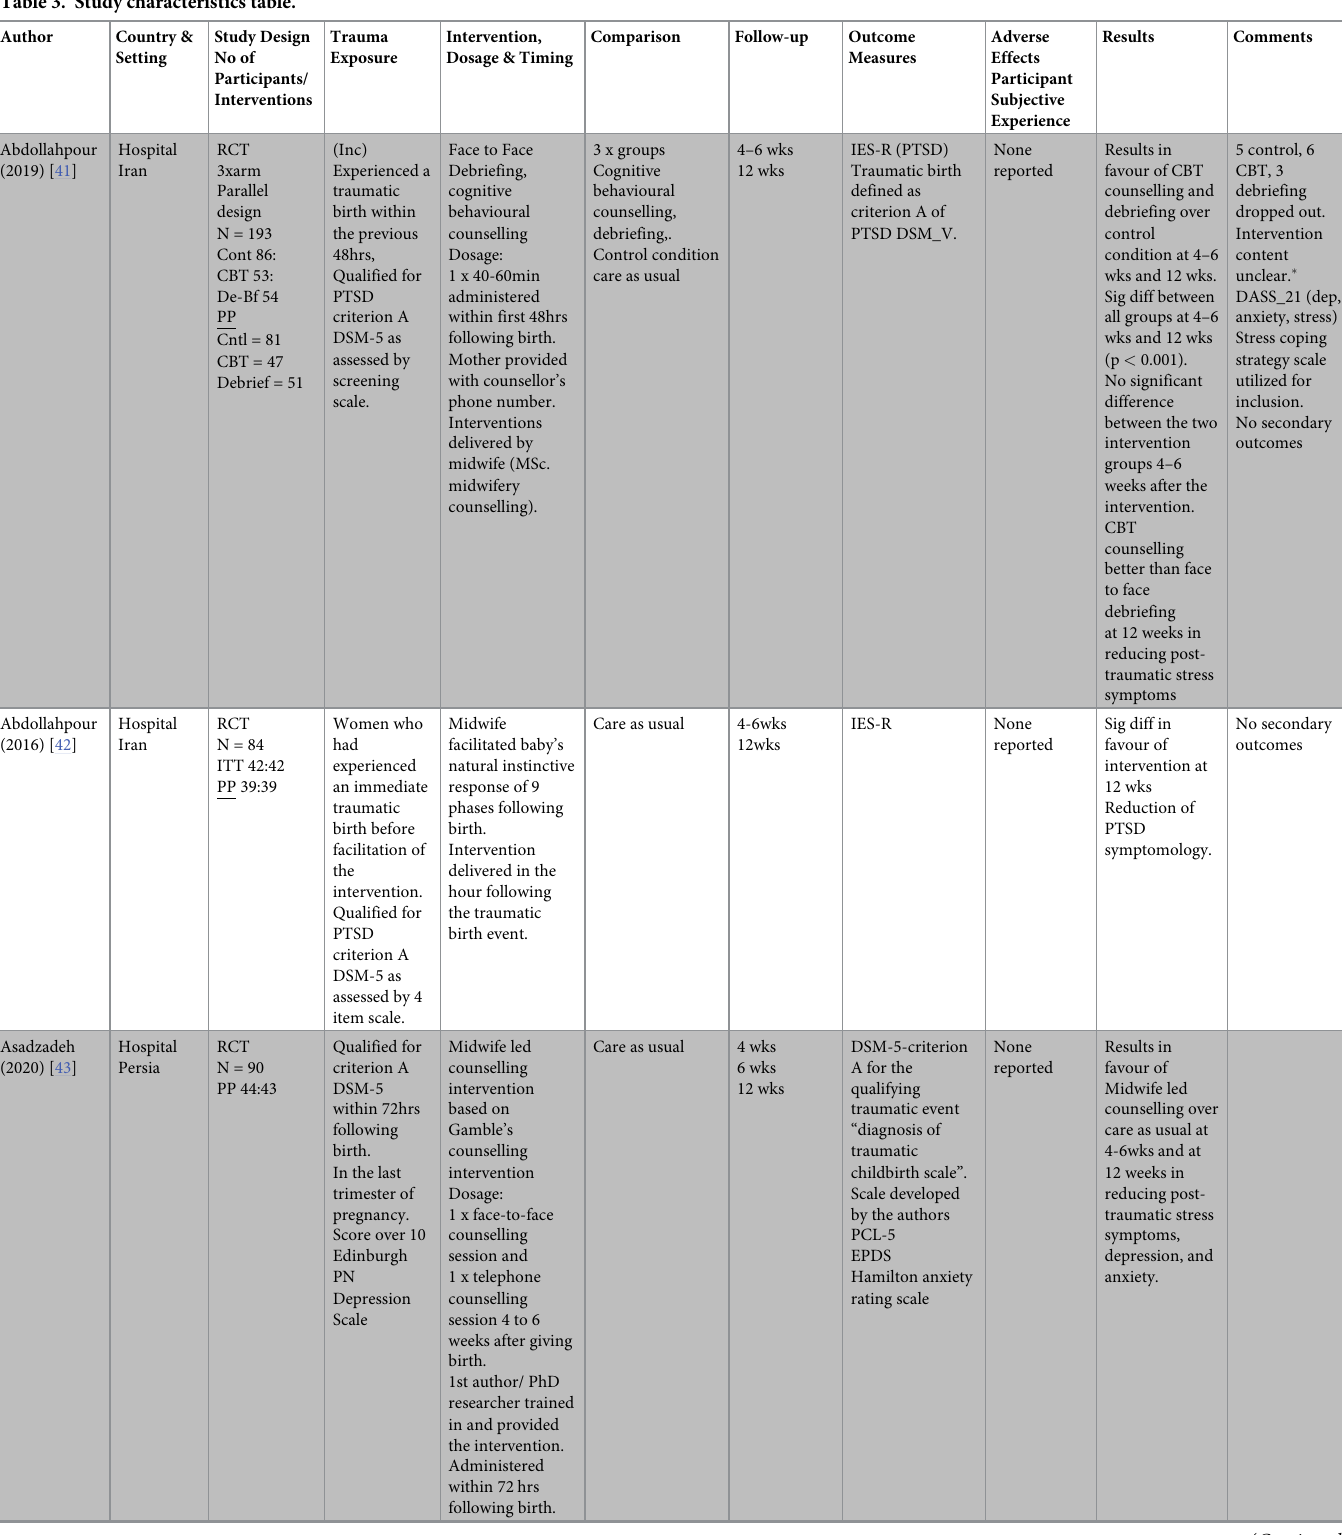
Table 3. Study characteristics